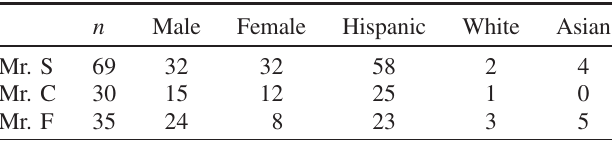
TABLE II. Gender and ethnicity distribution in the three physics